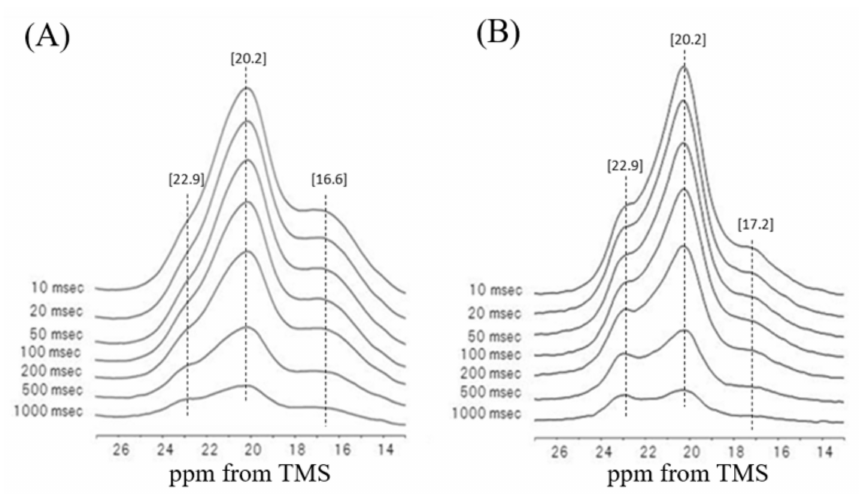
Figure 15. A series of partially relaxed 13 C CP / MAS NMR spectra of Ala C β peaks of [3- 13 C]Ala- N. clavata dragline silk fiber in the dry state ( A ) and in the hydrated state ( B ) [61].